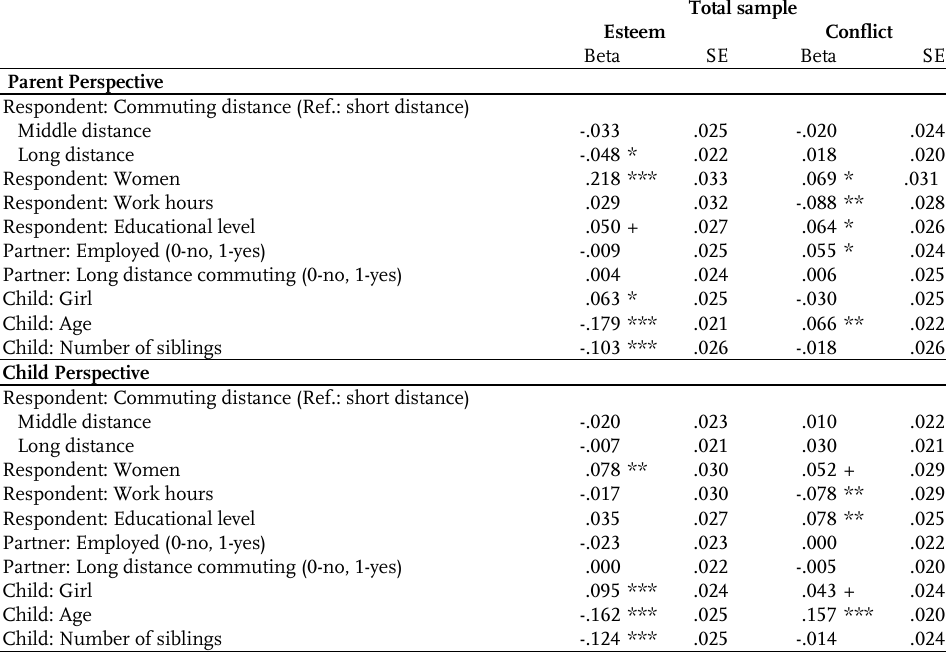
Total sample Esteem Conflict Beta SE Beta SE